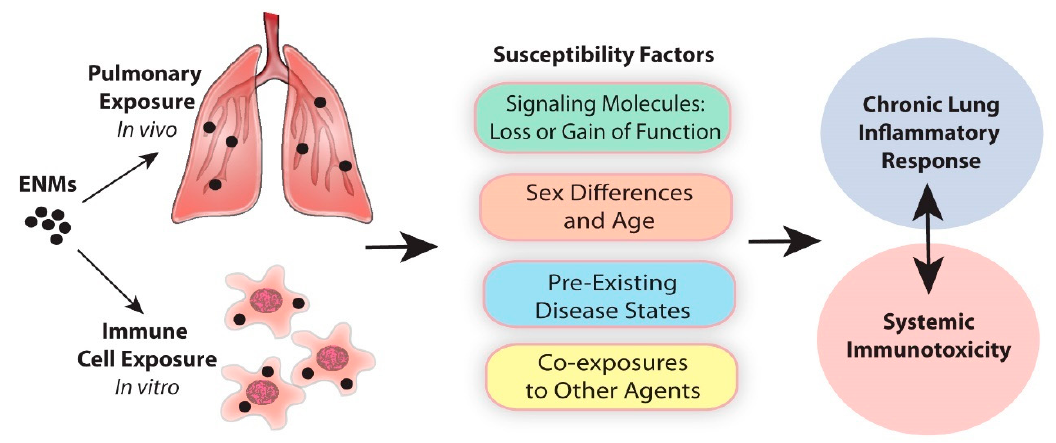
Figure 1. Susceptibility factors in the chronic lung inflammatory response to engineered nanomaterials